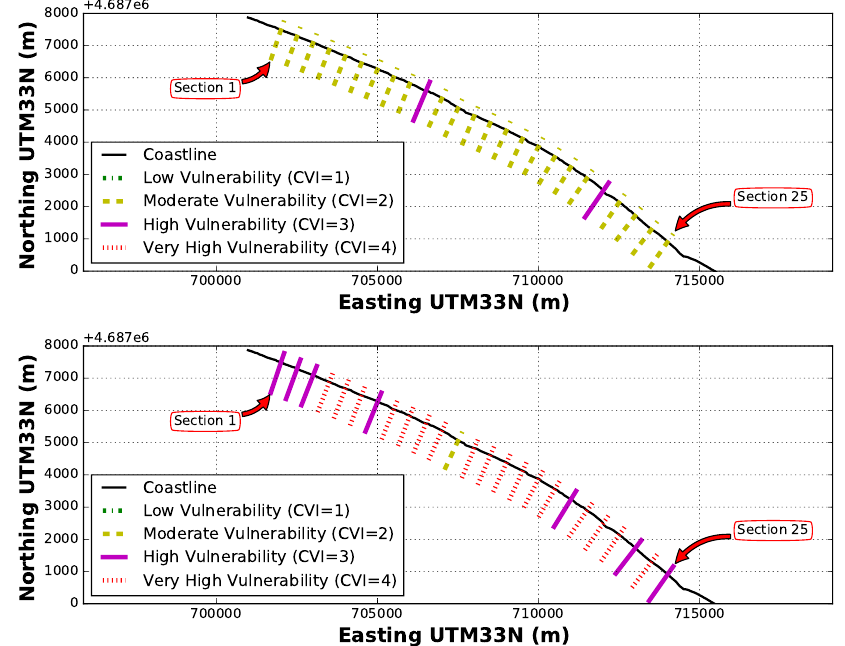
Figure 6. Coastal Vulnerability Index (CVI) for all the considered cross-sections by using local-scale data ( upper panel ) and national-scale data ( lower panel ). Section numbering, from 1–25, starts from north.